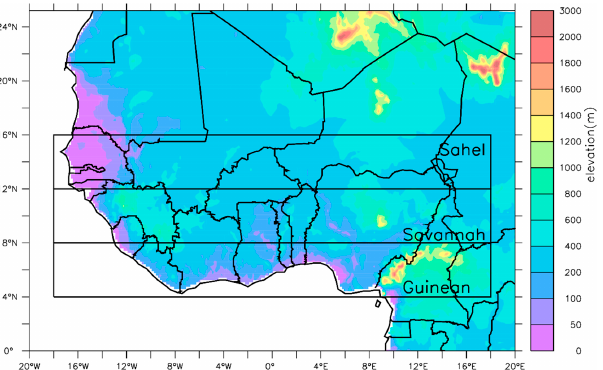
Figure 1. Study area with the three climatic zones (Guinea, Savannah, and Sahel) and the topography in meters (m) in West Africa. 2.2. Data The data used in this study are the current CORDEX-CORE simulations from the Word Climate Research Program (WCRP), the atmospheric reanalysis dataset (ERA5, [37]), developed by the European Centre for Medium-Range Weather Forecasts (ECMWF), as well as a satellite-based climate dataset (SARAH-2, [38]). The CORDEX-CORE simulation data used in this study are based on three RCMs namely: RegCM4, REMO, and CCLM, each driven by three GCMs (NorESM1-M, MPI-ESM-MR, and HadGEM2-ES) from the Coupled Model Intercomparison Project 5 (CMIP5, [39,40]). According to Giorgi et al. [41], these GCMs are among the best performing models in the CORDEX domains within the CMIP5 ensemble (e.g., [42,43]). They roughly span the range of global climate sensitivity of the CMIP5 ensemble, with HadGEM2-ES having high sensitivity, and MPI-ESM-MR and NorESM1-M having medium and low sensitivity, respectively, in terms of increase in global mean temperature compared to the pre-industrial level. RegCM4 is the fourth generation version of the RegCM regional modelling system Giorgi et al. [41] developed at the Abdus Salam International Centre for Theoretical Physics (ICTP). REMO is a hydrostatic atmospheric model using hybrid vertical coordinates developed at the Climate Service Center Germany (GERICS) [44,45]. CCLM is a non-hydrostatic model developed by the Consortium for Small-scale Modelling (COSMO) community. In addition, RCMs participating in CORDEX-CORE offer only two RCPs: RCP2.6 and RCP8.5 scenarios [40]. All three RCMs were frequently used for climate simulations in West Africa. Examples are shown by Sawadogo et al. [20] and Kouassi et al. [46] for RegCM, Paeth et al. [47] and Paxian et al. [48] for REMO, and Dosio and Panitz [49] and Dieng et al. [50] for CCLM. To study the future solar PV and wind energy potential, the climate variables taken from the CORDEX-CORE